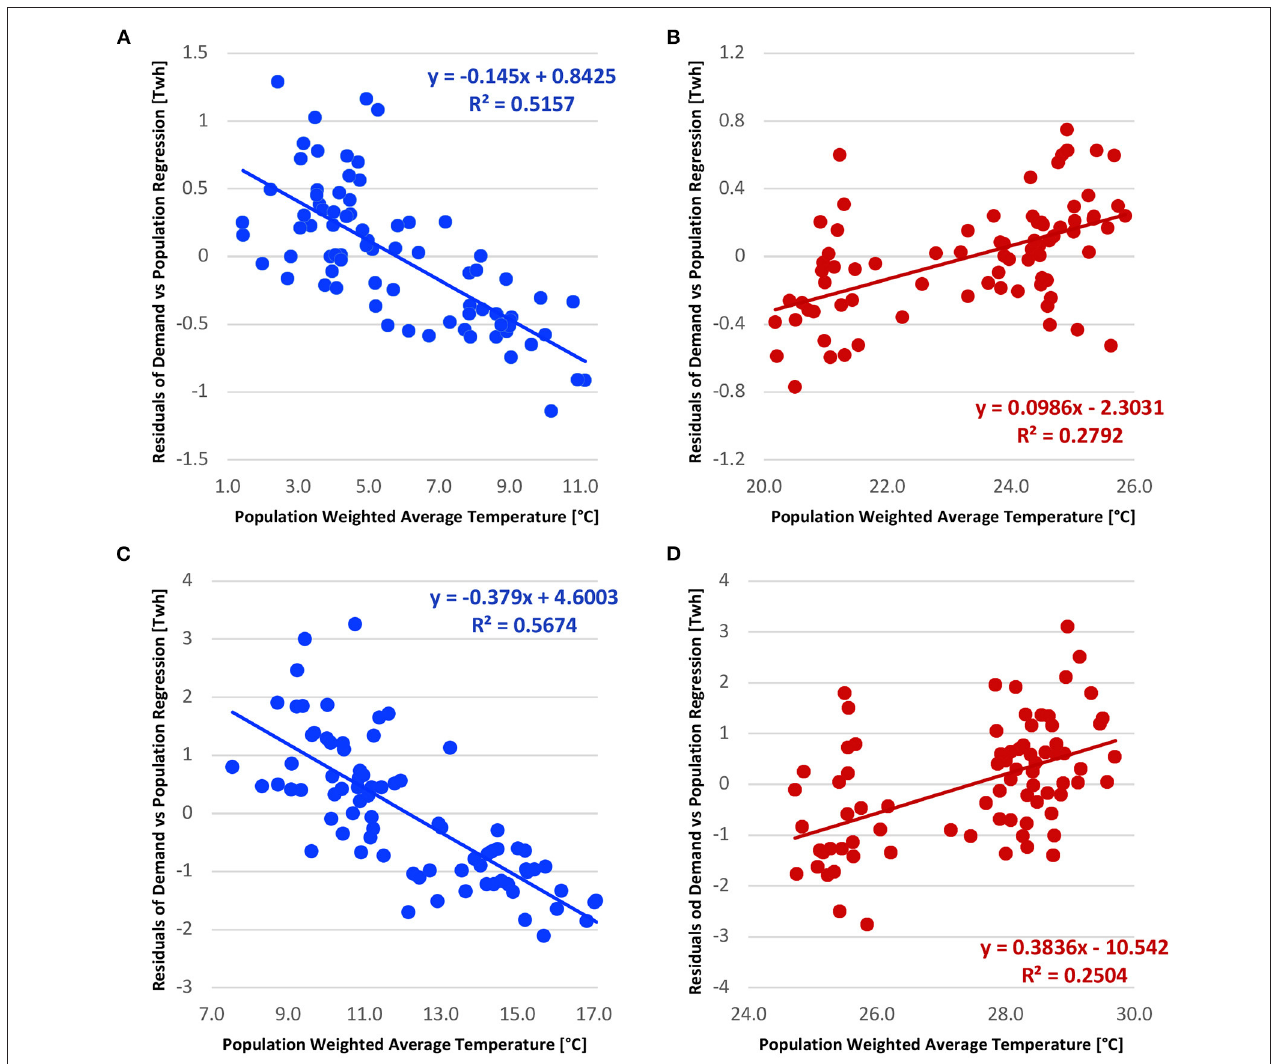
FIGURE 5 | Ability of the bias-corrected ECHAM4.5 seasonal average temperature forecast to explain the interannual variability of residuals obtained from the regression between observed power demand and population: (A) TN JFM, (B) TN JAS, (C) TX JFM, and (D) TX JAS. Residuals corresponding to winter (summer) months are indicated in blue (red)